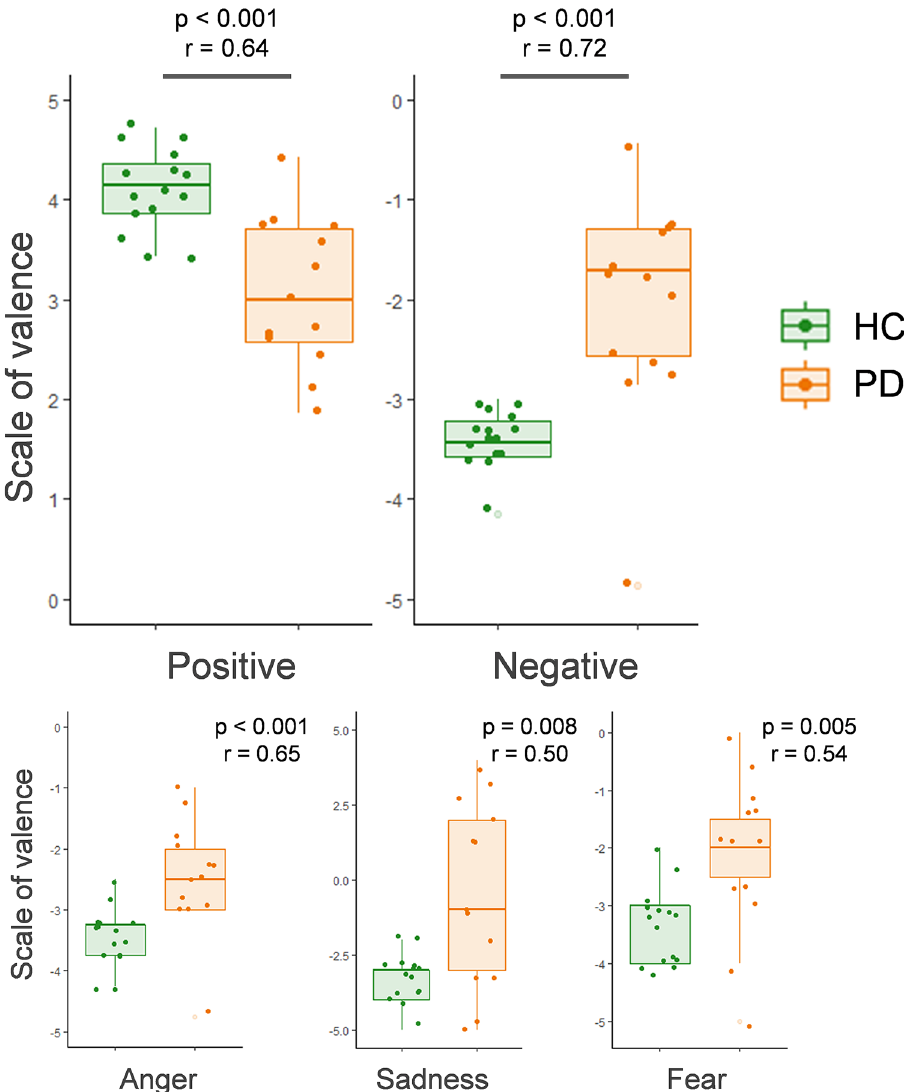
Figure 1. Boxplots comparing valence judgments of PD and HC participants, presented respectively as a function of the two main valence conditions (positive/negative) (top) and for each negative emotion separately (bottom). Note that the used subjective scale went from − 5 (very negative) to 5 (very positive). The y axis limits are [0;5] for positive emotions and [− 5;0] for negative emotions, except for sadness (y axis [− 5;5]). P -values ( p ) and effect size ( r ) of the Wilcoxon Mann–Whitney tests are indicated in the plot. PD = Parkinson’s disease patients, HC = Healthy